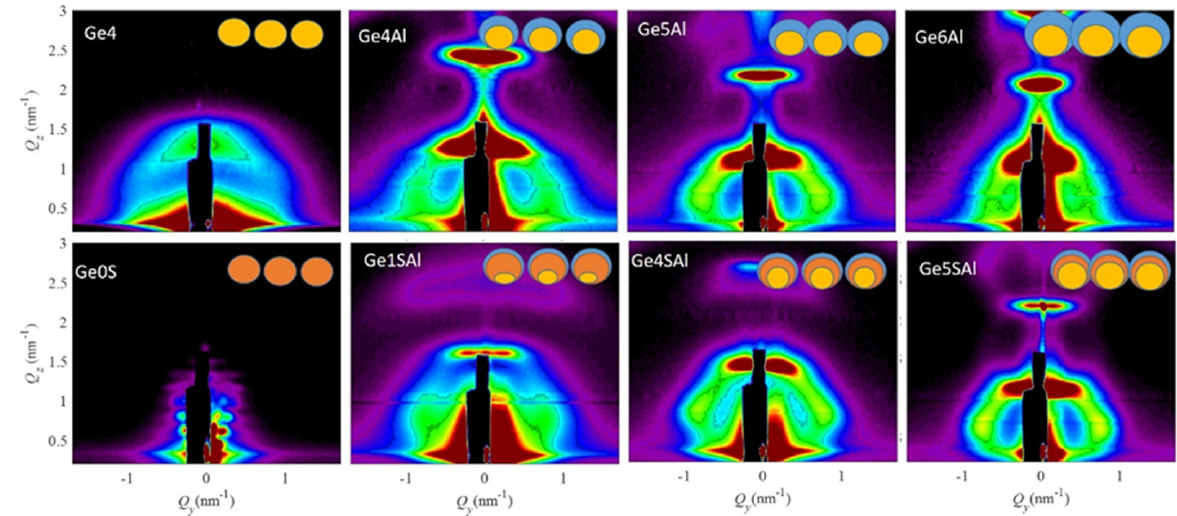
Figure 1. GISAXS maps of all the studied samples. The insets show schematic images of different QD structures that appear in the investigated films. The Ge core is indicated by yellow colour, the Al shell by blue colour, and the Si 3 N 4 shell by orange colour.